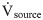
Signal processing overview from polygraph data to its breathing profile simulated on bench.The signal processing steps or steps refer to the main steps described in polygraph signal processing section. (a) Polygraph nasal airflow, steps 1 and 2: nasal airflow (V˙source) of period without movement artifact is derived from polygraph raw signals. It represents the target breathing airflow, which is aimed to be simulated on bench. (b) Sleep disordered breathing events characterization, steps 3, 4 and 5: breathing onset positions (*) and sleep disordered breathing (SDB) events (orange frames) are identified. SDB events can be obstructive apneas (OA), central apneas (CA), obstructive hypopneas, central hypopneas. (c) Central command airflow calculation, step 6: the estimated non-obstructed nasal airflow issuing from central ventilation command (V˙cc) is calculated by combining information of V˙source and SDB events characterization. During normal breathing periods or central SDB events, V˙cc is directly assumed identical to V˙source, whereas during obstructive breathing events, the amplitude of V˙cc is hypothesized to be equal to V˙source amplitude of the pre-event 2-minute baseline. (d) Muscular effort pressure calculation, step 6: the respiratory muscular effort pressure (ΔPmus) is calculated by taking into account V˙cc as well as the lung compliance and airway resistance set in the active lung simulator. (e) Upper airway obstructive level calculation, step 6: the sealed chamber pressure (Pch) used to regulate Starling resistor for each breathing cycle is calculated as a function of V˙cc and V˙source. (f) Bench airflow simulation: the bench-simulated airflow (V˙bench) is obtained by controlling the active lung simulator and the Starling resistor with ΔPmus and Pch.